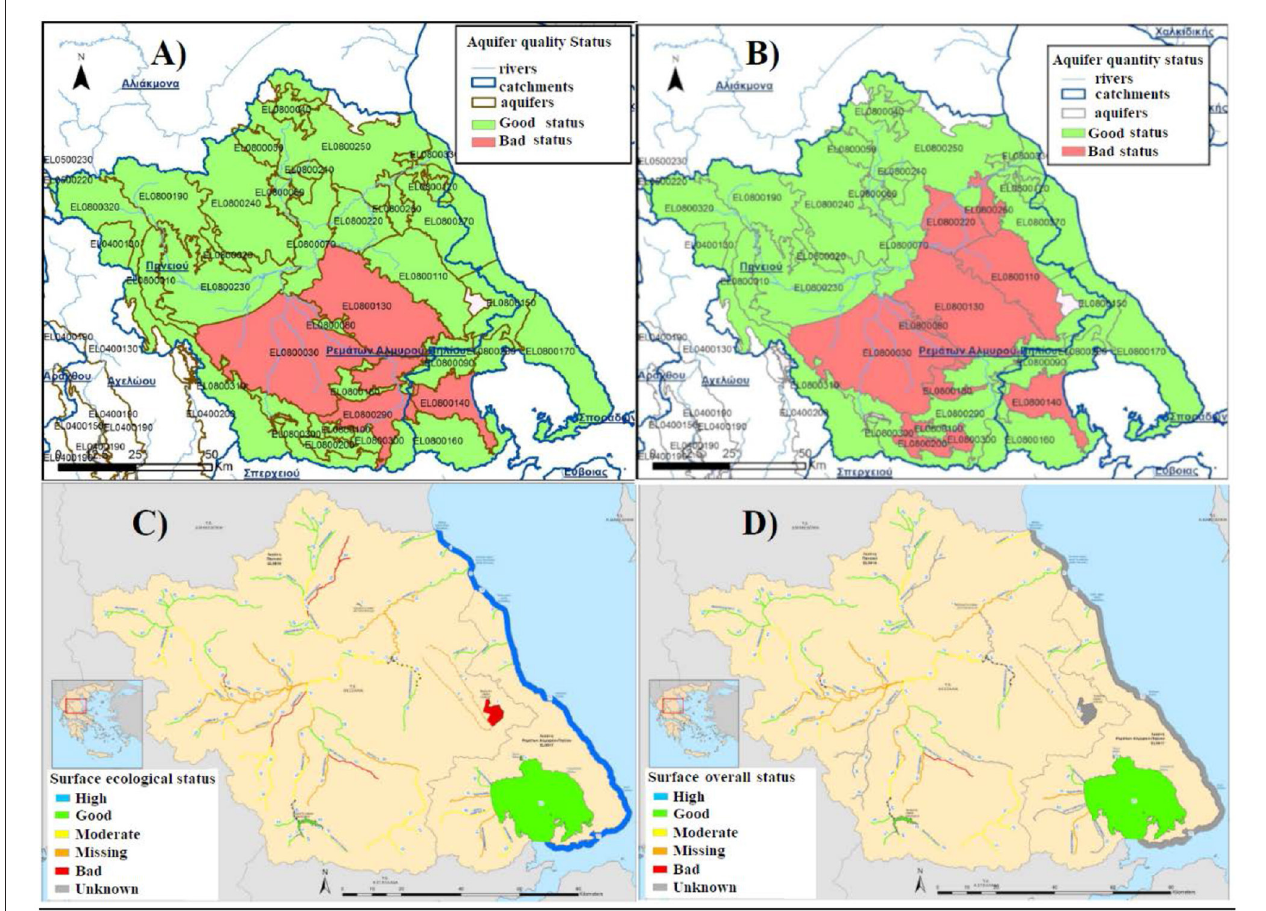
FIGURE 2 | (A) qualitative and (B) quantitative status of groundwater WBs. (C) ecological and (D) overall status of surface WBs (Adapted from GMECC,